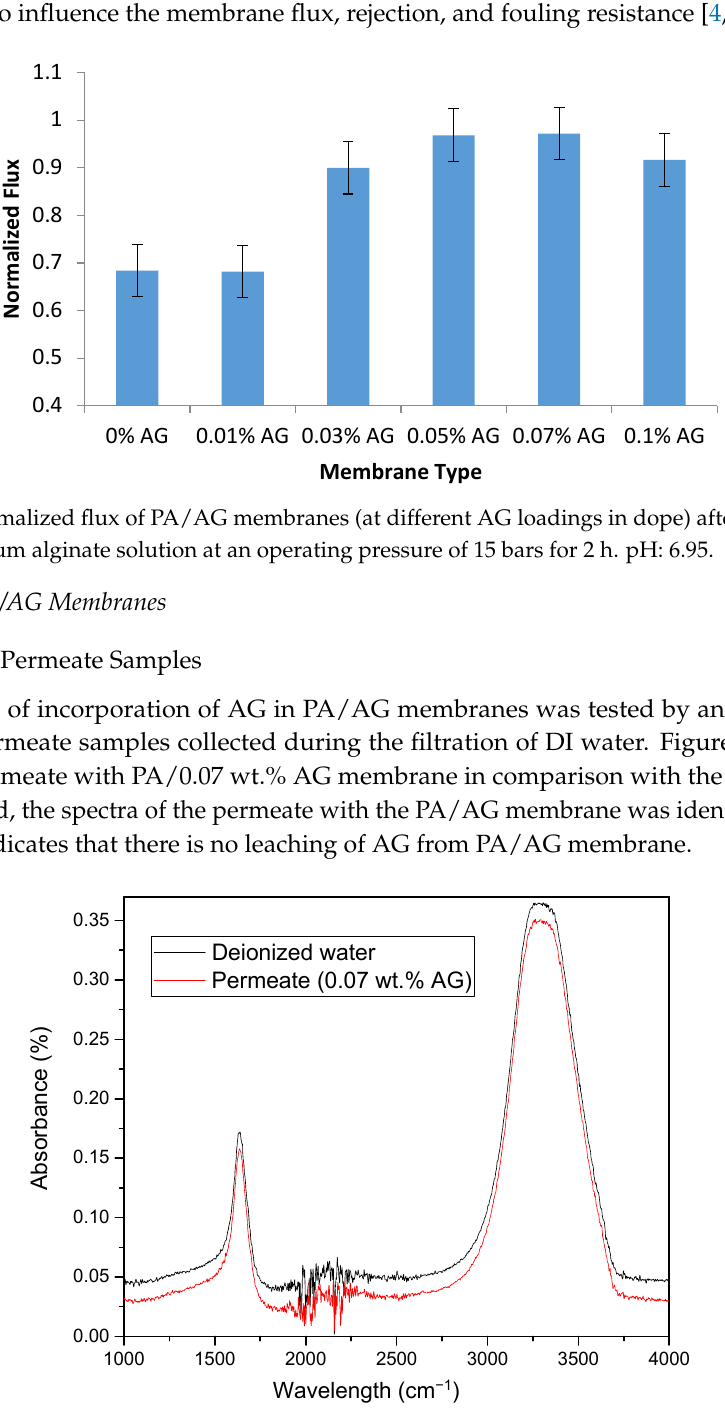
Figure 9. FTIR spectra of the permeate with PA/0.07 wt.% AG membrane in comparison with the spectra of DI water.